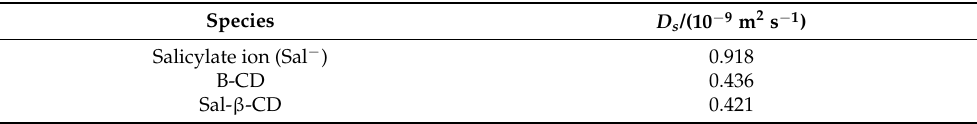
Table 3. Limiting diffusion coefficients, D s , of different species in the solution at T = 298.15 K and P = 101.3